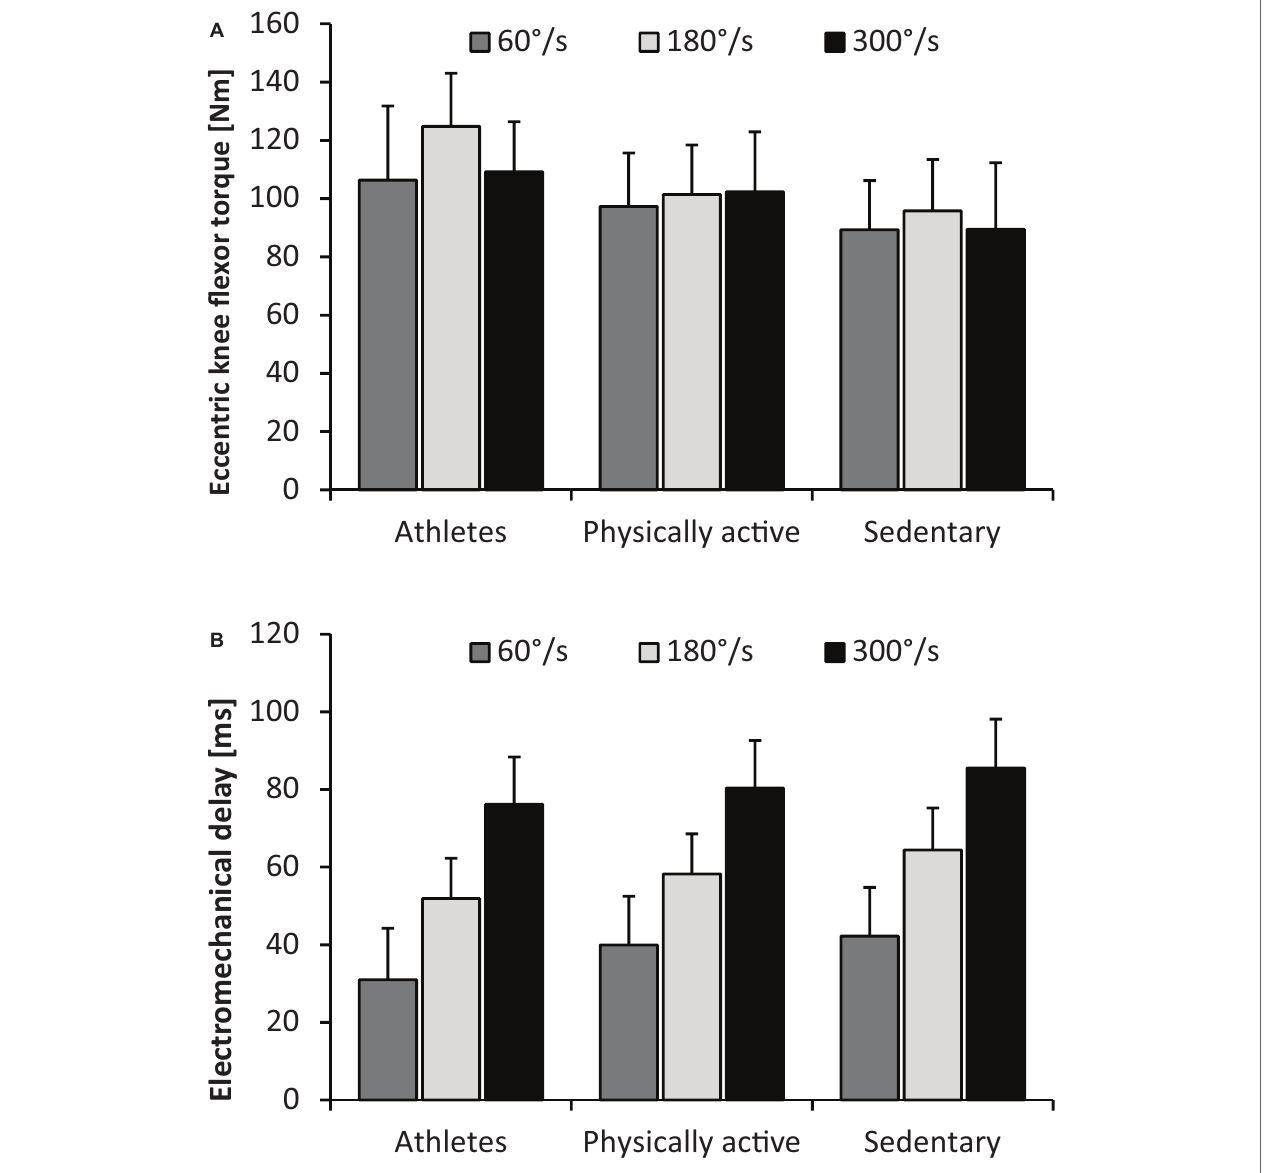
FIGURE 2 | Means and standard deviations of maximal eccentric knee flexor strength [i.e., torque (A) ] and electromechanical delay (B) in athletes, physically active and sedentary participants at different angular velocities during isokinetic testing (i.e., 60, 180, and 300 ° /s). Data were adjusted for baseline